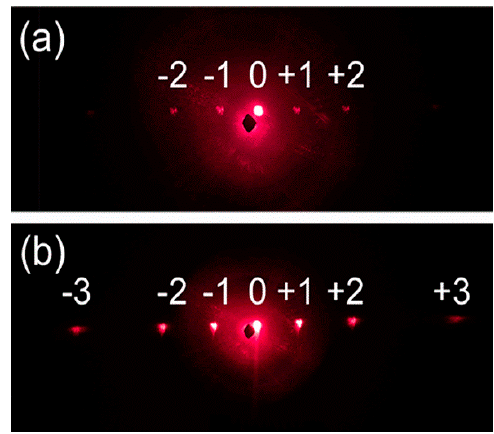
Figure 6. ( a ) Diffraction pattern of the nanograting structure before etching; ( b ) diffraction pattern of the grating structure after etching.